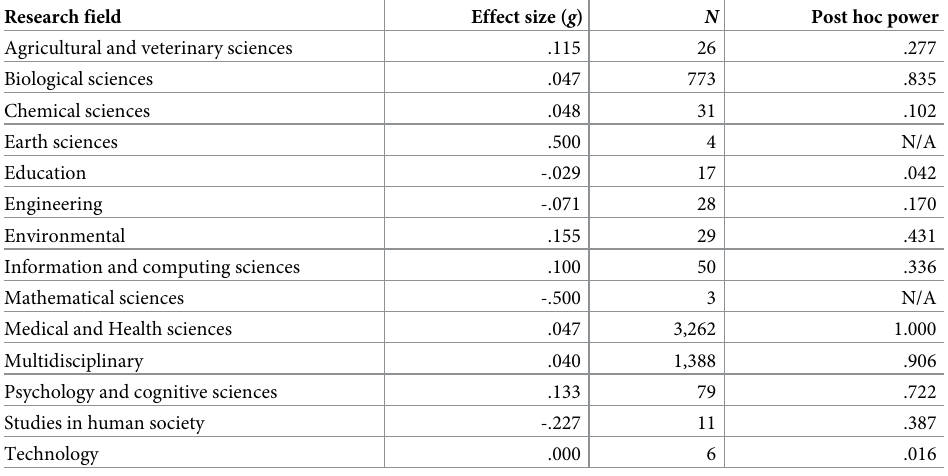
Table 2. Post-hoc power analyses of Head et al.